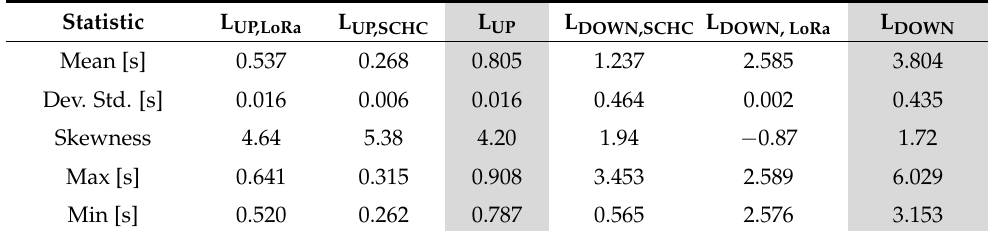
Table 3. Statics of metrics evaluated when the LoRaWAN backend is located in Milan. Statistic L UP,LoRa L UP,SCHC L UP L DOWN,SCHC L DOWN, LoRa L DOWN Mean [s]